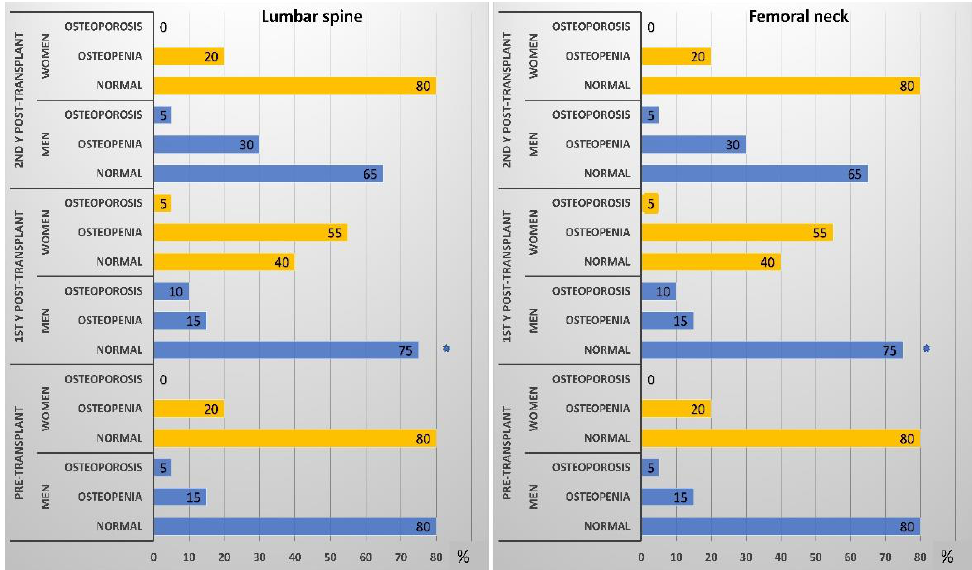
Figure 5. Prevalence of osteopenia and osteoporosis in men and women groups throughout the study period (* means significantly different between men and women by Mann–Whitney U test).